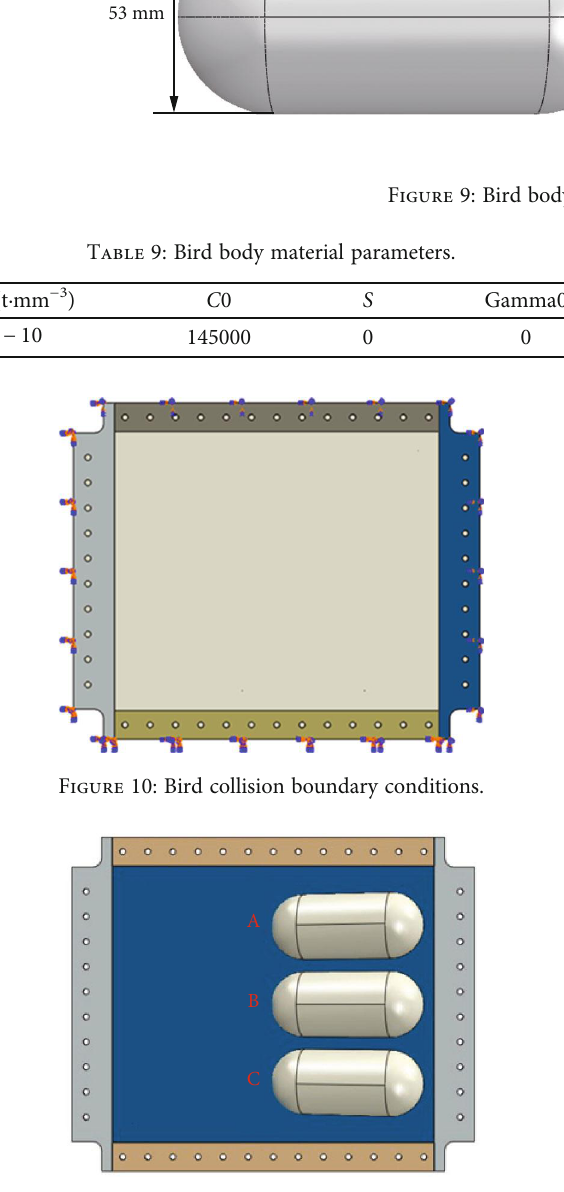
Figure 11: Schematic diagram of the bird body impact